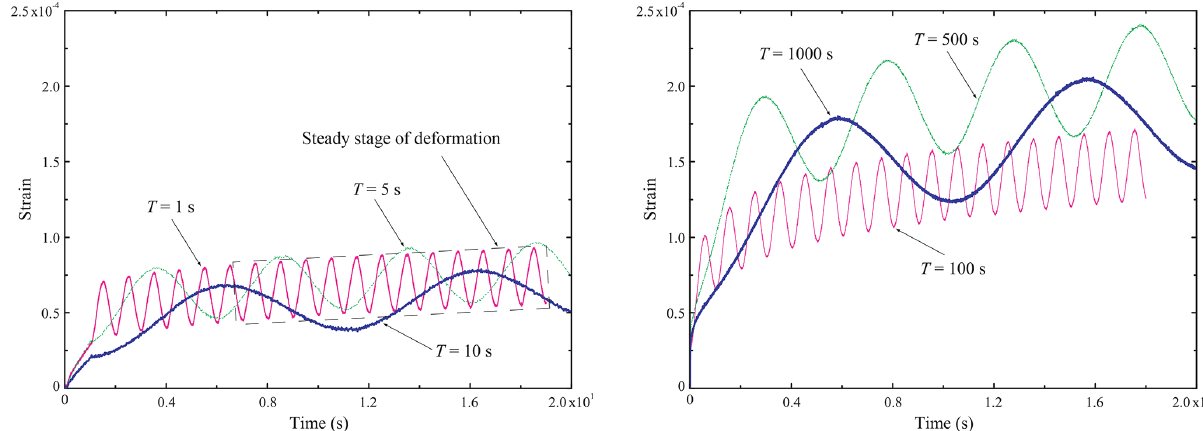
Figure 8. Strain-time curves of specimen Dry-5ppt-1 tested with stresses varying from 0.08 to 0.25MPa and with a temperature of − 10 ◦